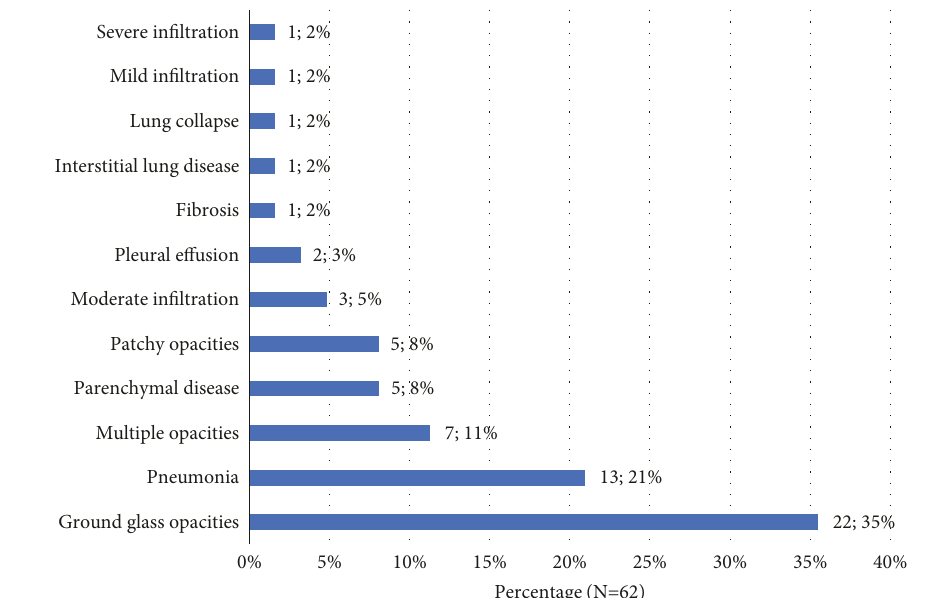
Figure 4: Chest CT findings among patients admitted with COVID-19 at case hospital, Uganda ( n � 71). Data label presented as frequency;